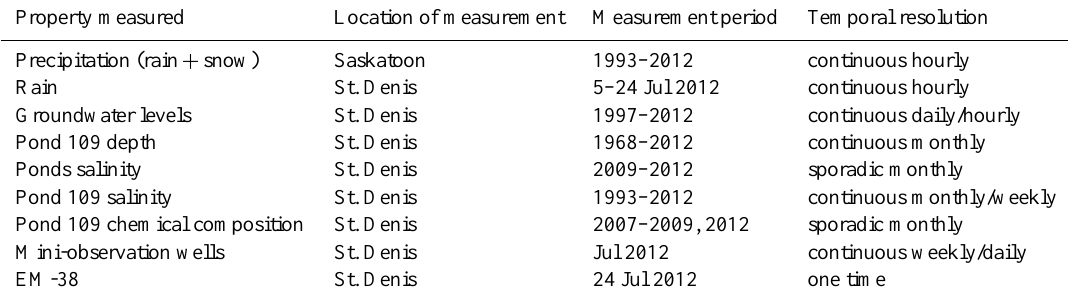
Table 1. Measurements locations, periods, and temporal